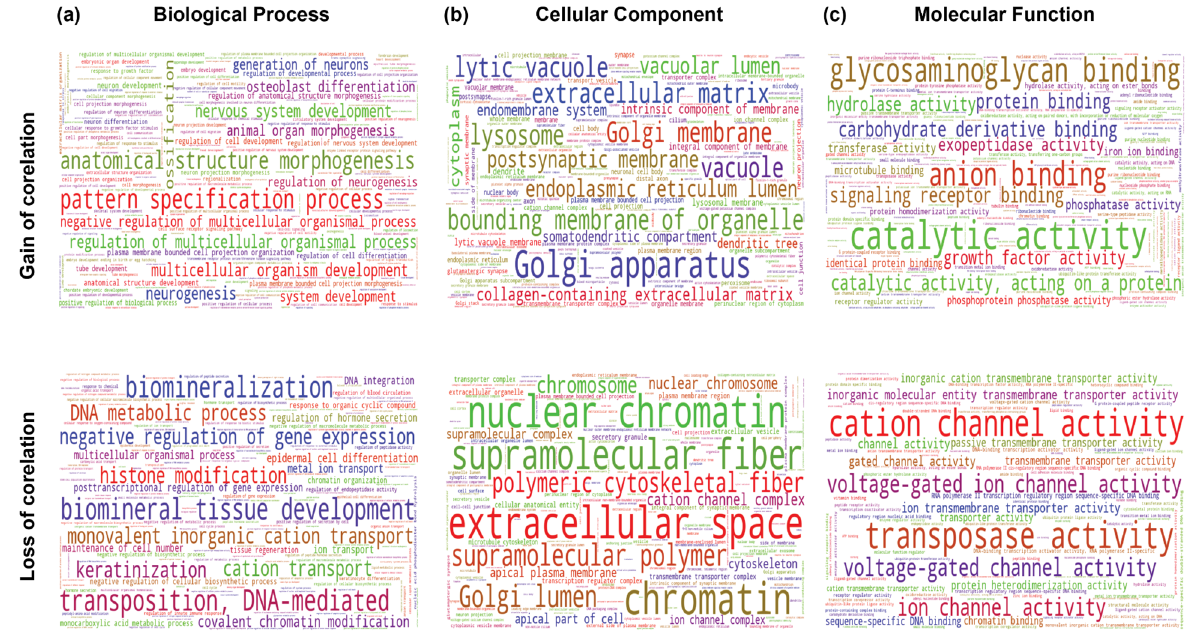
Figure 12. Gene Ontology analysis of genes differentially correlated with THAP9 in normal vs. tumor samples (top—genes that gained a correlation with THAP9; bottom—genes that lost a correlation with THAP9). Word clouds of enriched ( a ) GO biological process, ( b ) GO cellular component, and ( c ) GO molecular functions. The differential gene correlation analysis, followed by the gene ontology analysis for the differentially correlated genes, was performed using the DGCA package in R.